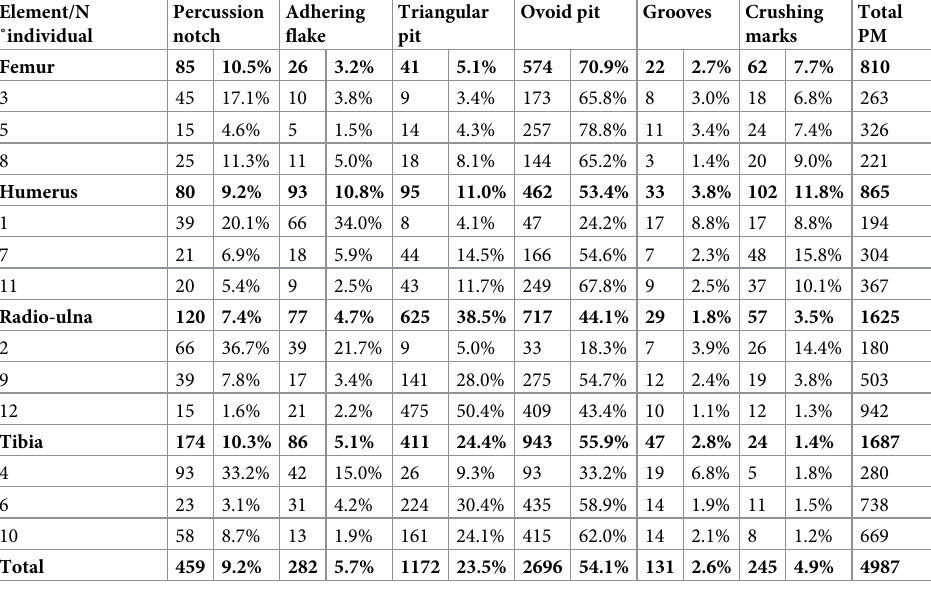
Table 6. Type of percussion marks by individual and by element on